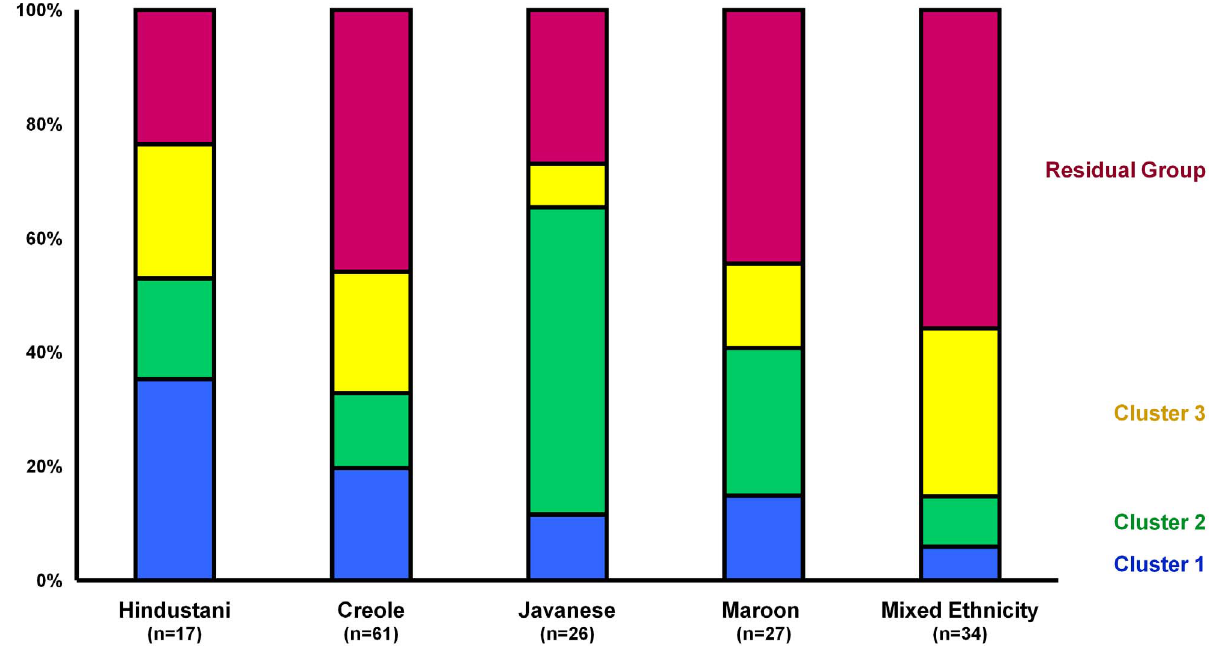
Figure 2. Distribution of individuals in Chlamydiatrachomatis clusters within ethnic groups in Paramaribo, Suriname, 2008–2010. Colors indicate cluster: Blue – cluster 1; Green – cluster 2; Yellow – cluster 3; Pink – residual group.